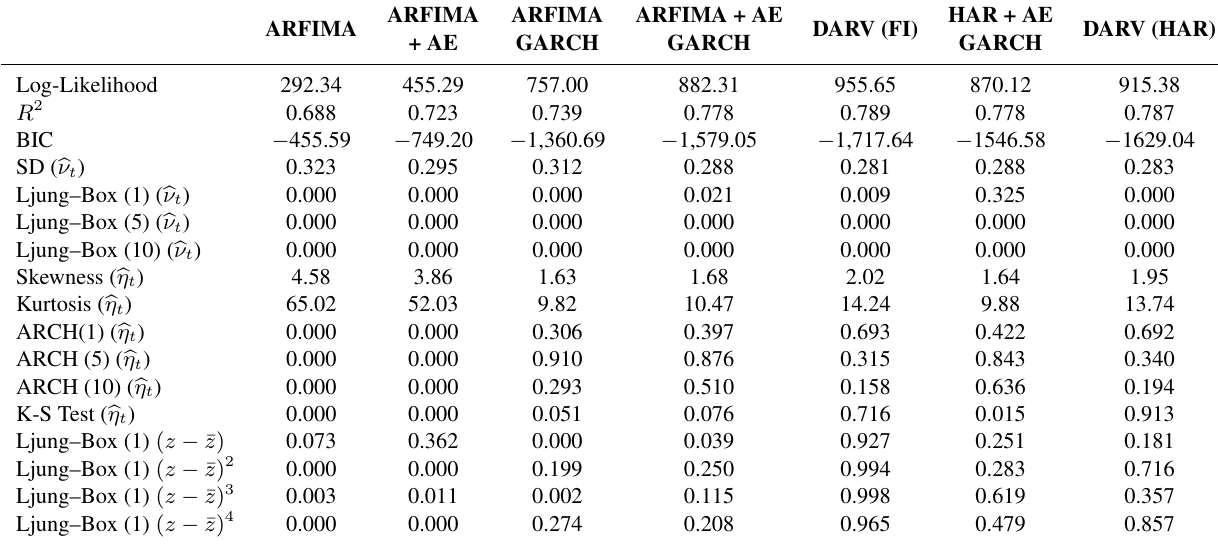
Table 6. Estimation diagnostics (S&P